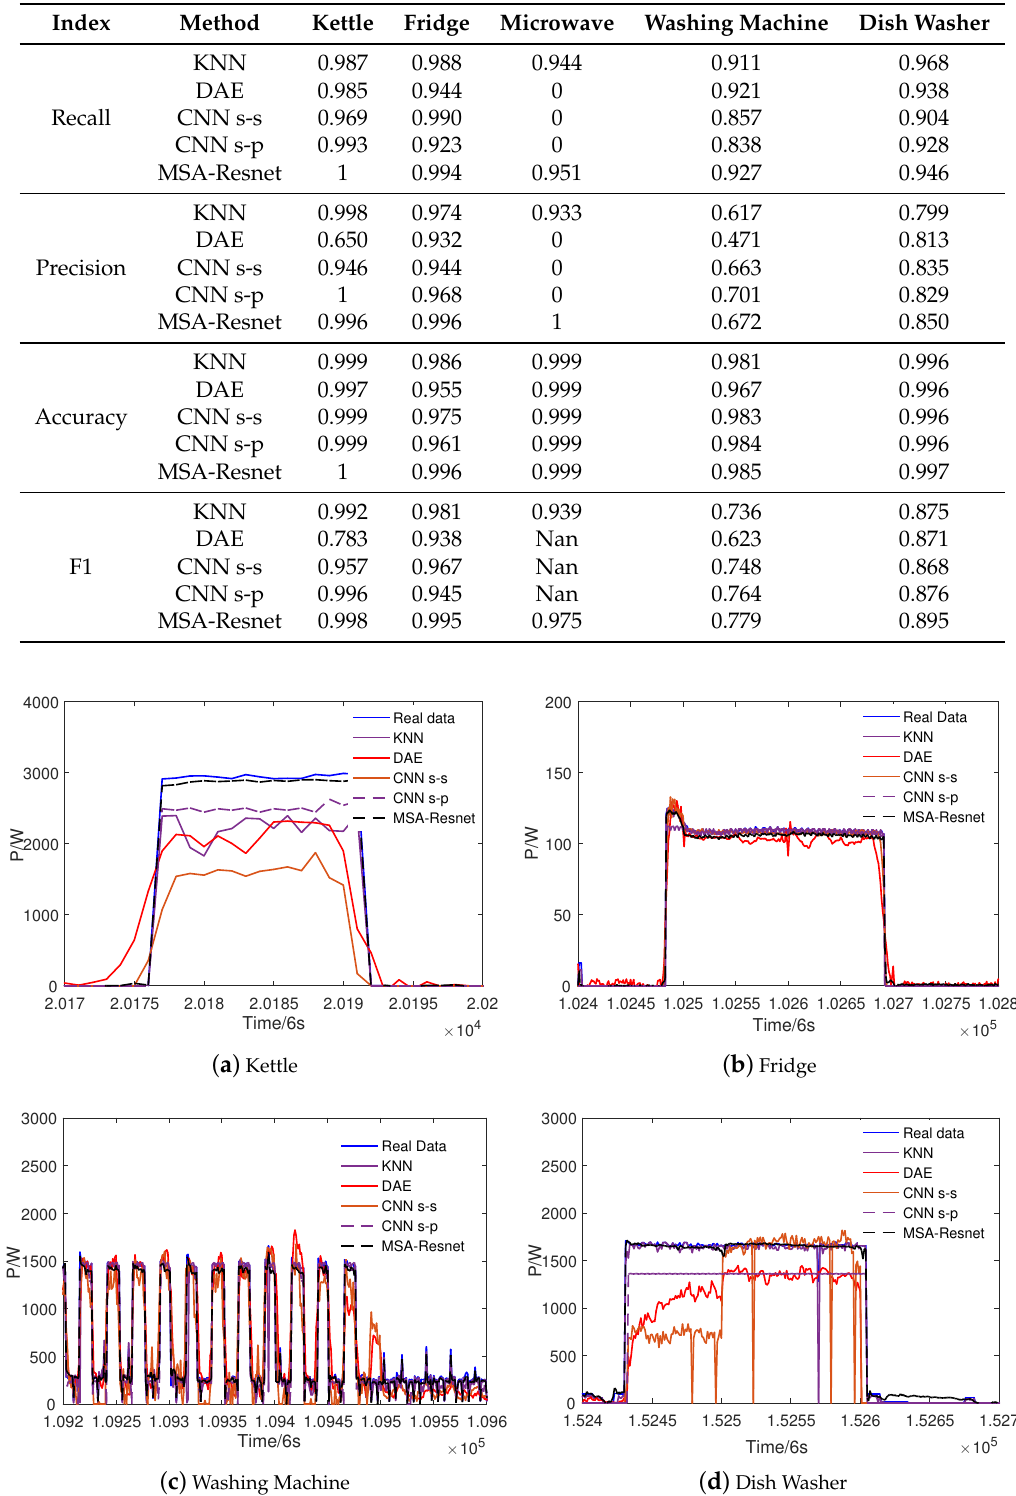
Figure 10. Load disaggregation comparison for Household 5 of the UK-DALE